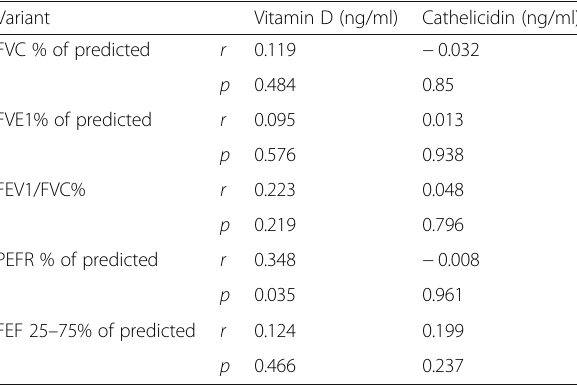
Table 3 Vitamin D and cathelicidin correlations with different spirometry indices in asthmatics Variant Vitamin D (ng/ml) Cathelicidin (ng/ml) FVC % of